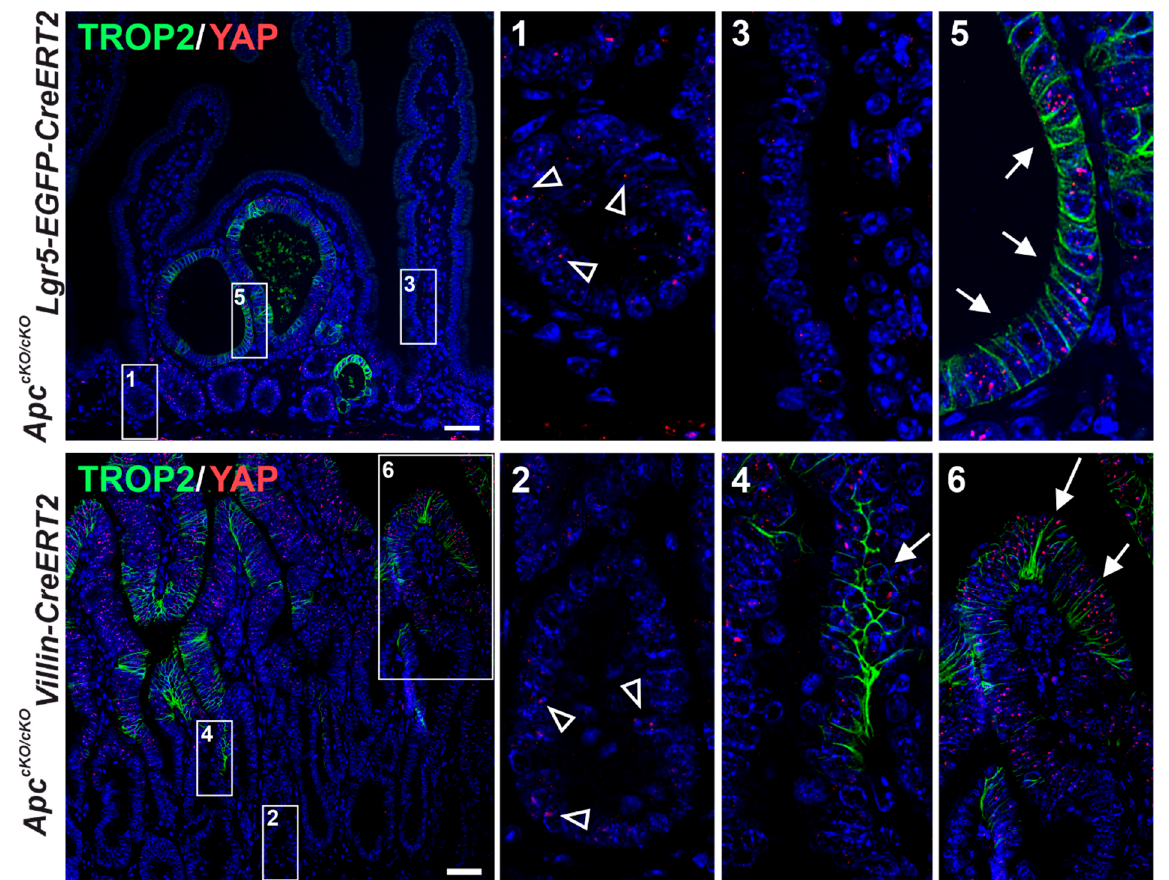
Figure 8. Immunodetection of Trop2 and YAP in the small intestine of the indicated mouse strains 6 weeks (top images) and 7 days (bottom images) after Apc inactivation. Images in insets are magnified on the right; samples were counterstained with DAPI. Arrowheads in the magnified images (1) and (2) indicate nuclei in WT crypts that are sparsely positive for YAP, whereas healthy epithelium on the villus is predominantly YAP negative (3). White arrows mark areas of transformed epithelium at the villus edge of the crypt (4), in adenomas (5), or at the villus tip (6) with Trop2 expression and YAP nuclear localization; scale bar: 50 µm.